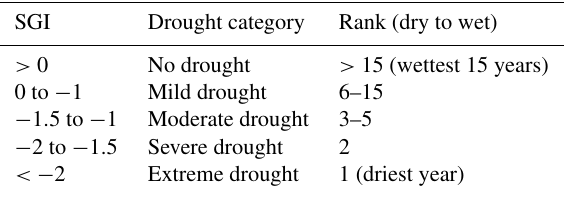
Table 2. Categories used for the standardised groundwater index, with the corresponding groundwater level rank in a 30-year